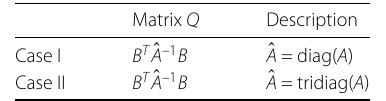
Table 1 Choices of matrix Q for Example 4.1